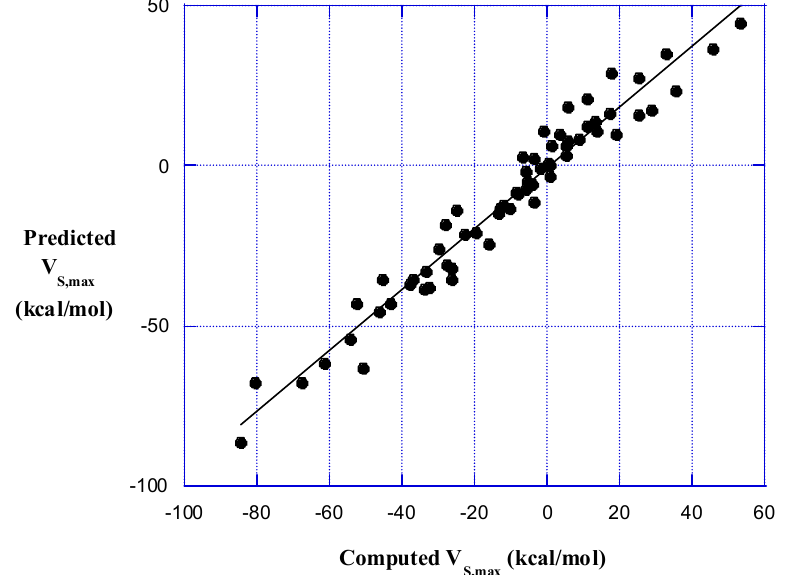
Figure 3. Relationship between predicted and computed V S,max and V S,min of halogen atoms X in H n A–X molecules. The R 2 is 0.953.